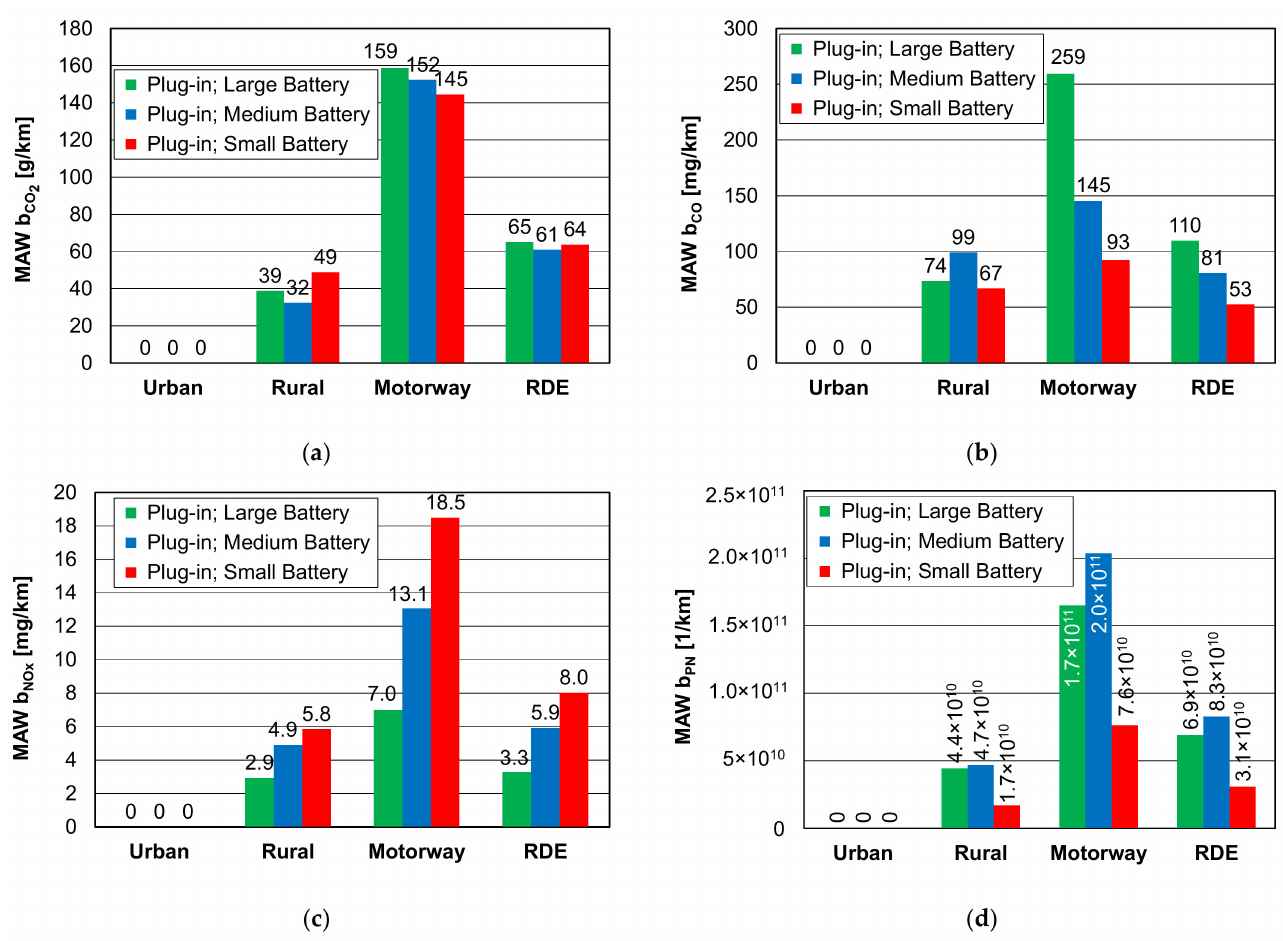
Figure 7. Road emission of carbon dioxide ( a ), carbon monoxide ( b ), nitrogen oxides ( c ), and particle number ( d ) for each phase of the test and in the entire RDE test for individual plug-in hybrid vehicles; the values were determined using an algorithm allowing for averaging in the measurement